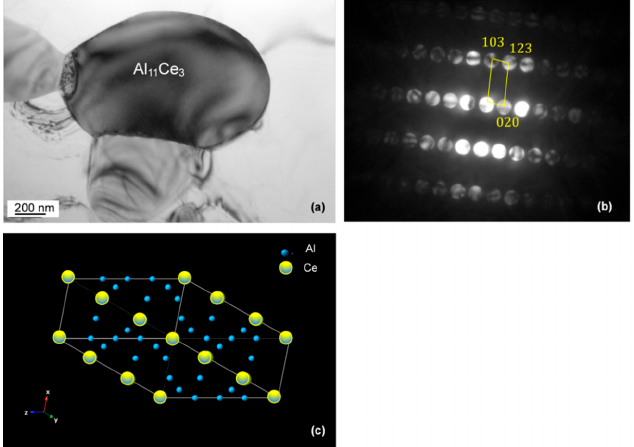
Figure 13. TEM bright field image ( a ) and the accompanied CBED pattern ( b ) showing the crystallographic identification of the Al 11 Ce 3 eutectic phase. The crystal structure of Al 11 Ce 3 is shown in ( c ). Alloy: Al–5Ce.